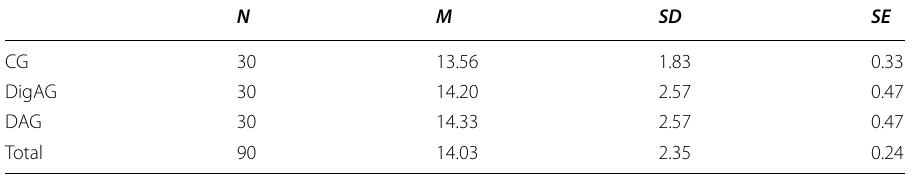
M mean, SD std. deviation, SE std. error